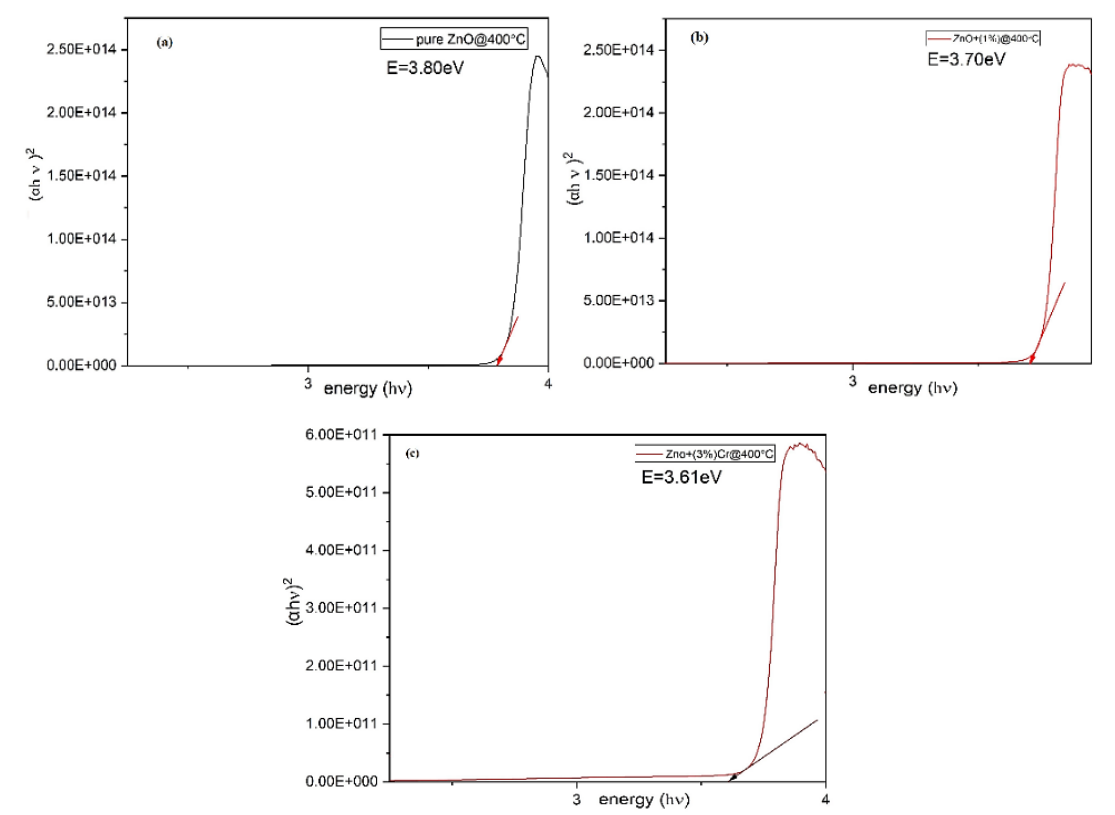
Figure 4. (a), (b) and (c) Plot of (αhν) 2 vs hν Zn (1-x) Cr x O (x = 0, 0.1and 0.3) nanoparticles respectively.